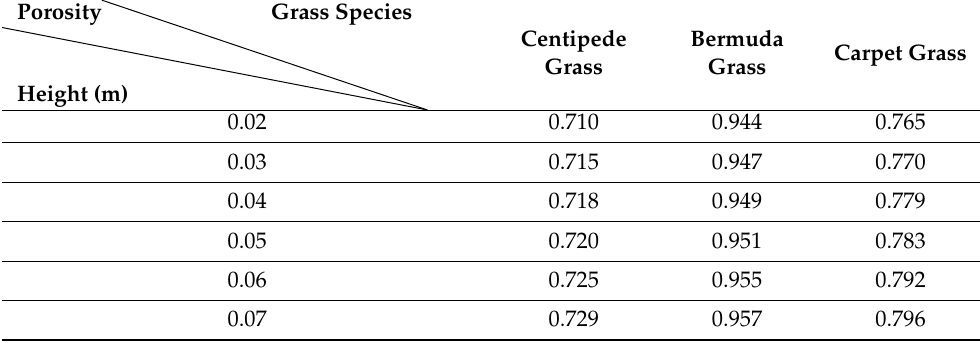
Table 5. Grass layer porosities for different heights and different grass